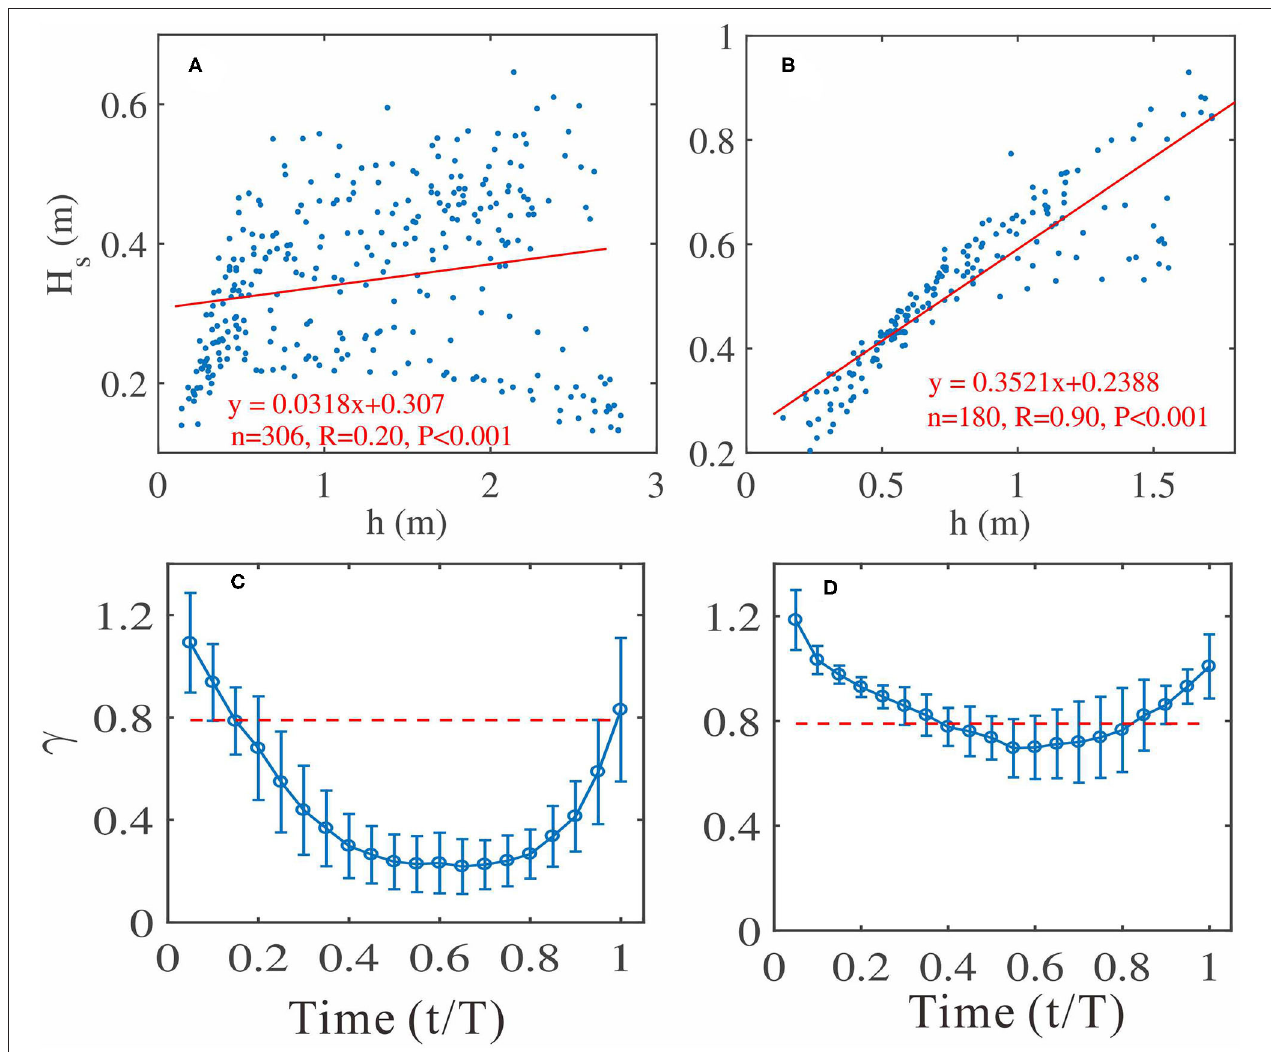
FIGURE 10 | H s against h under (A) low-energy and (B) moderate wave conditions. Averaged relative wave height ( γ ) against normalized tidal cycle (t/T) under (C) low-energy wave conditions and (D) moderate wave